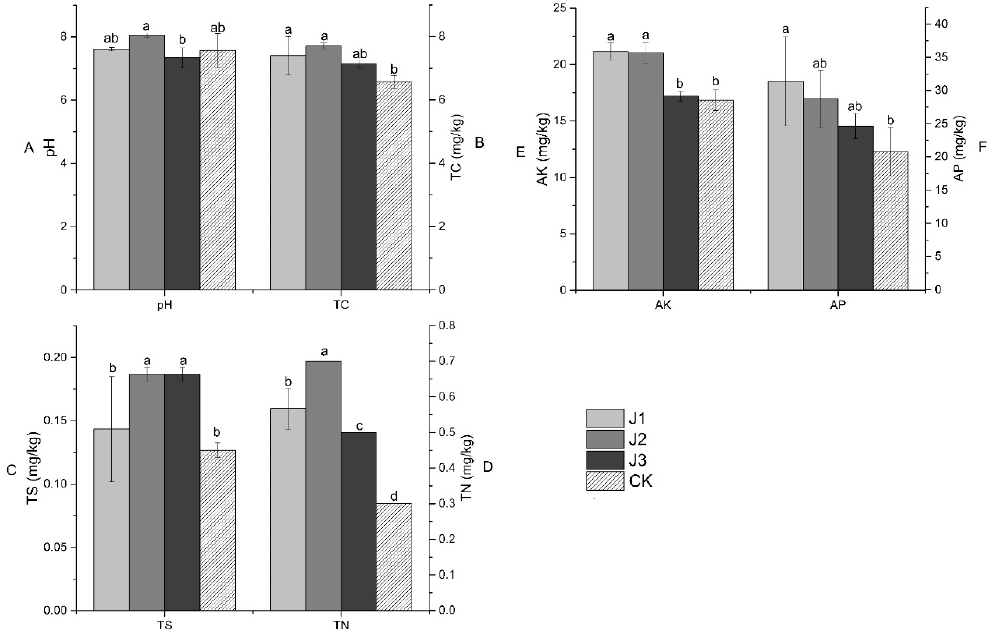
Figure 3. The responses of soil nutrients in the rhizosphere of R . pseudoacacia to applications of mineral-solubilizing microorganisms. Error bars are standard errors of the mean ( n = 3). ( A – F ) Different letters indicate significant differences ( p < 0.05) among the different treatments following a Duncan’s test. Experimental treatments: J1, NL-11; J2, NL-11 + NL-15; J3, NL-1 + NL-11 + NL-15. TC, soil total carbon; TN, soil total nitrogen; TS, soil total sulfur; AP, available phosphorus; AK, available potassium.